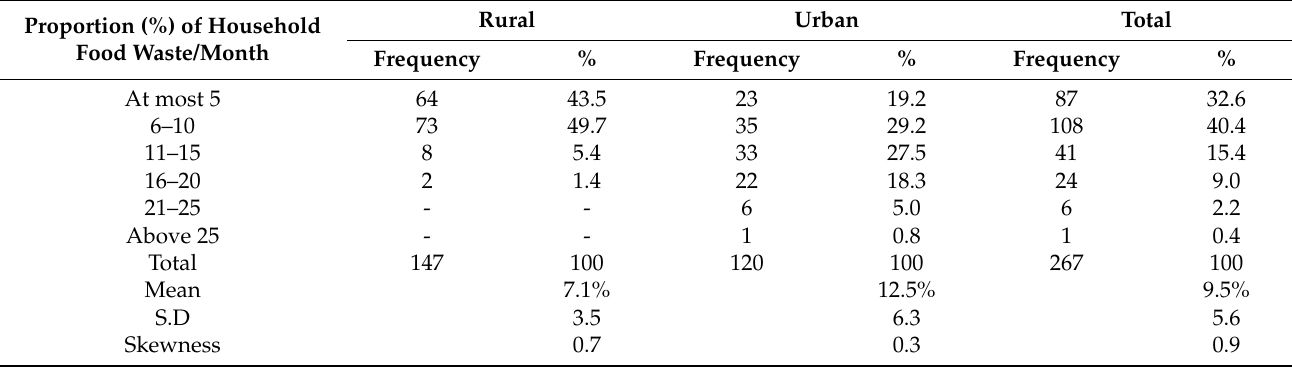
Table 3. Distribution of household food waste proportion per month.